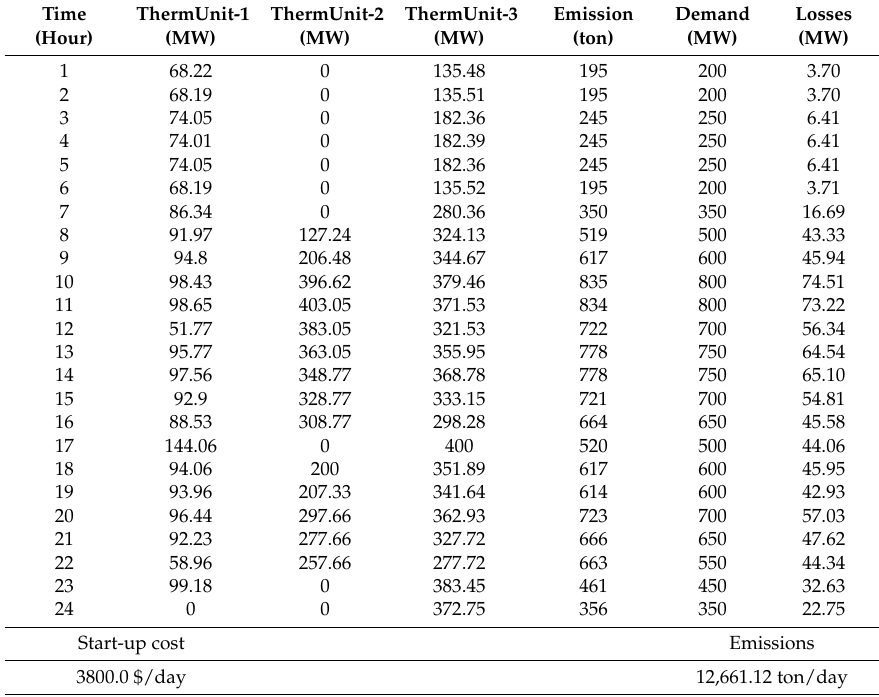
Table 6. Base case of 3 coal-fired generators implementing by the GSA.